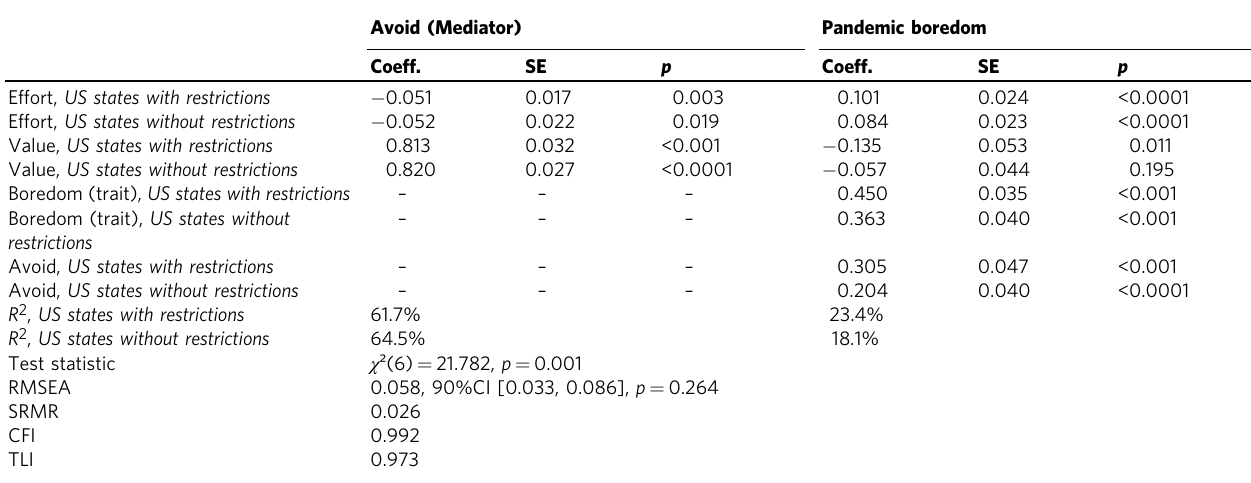
Table 6 Regression coef fi cients, standard errors, and summary information for the winter holidays model fi tted in US states with restrictions and US states without restrictions (multigroup